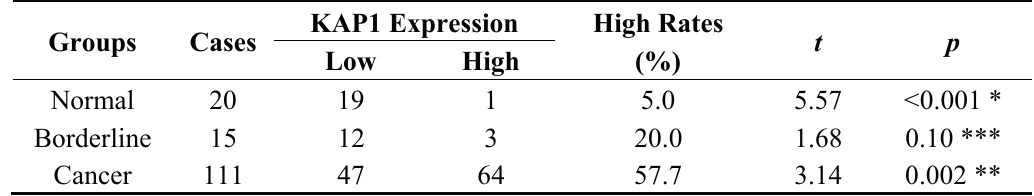
Table 1. Expression of KAP1 in different ovarian tissues.